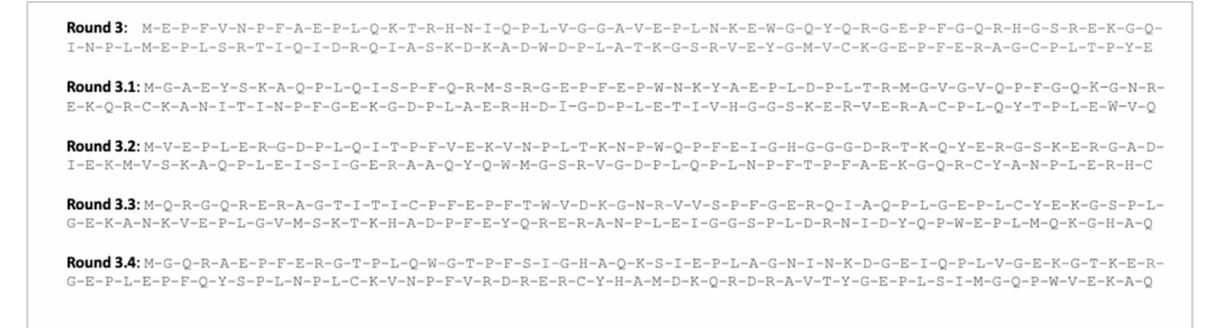
Figure 2. Original 108-amino acid sequence (Round 3) and refined sequence with 112 amino acids modeled for complete digestion (Round 3.1, Round 3.2, Round 3.3 and Round 3.4).